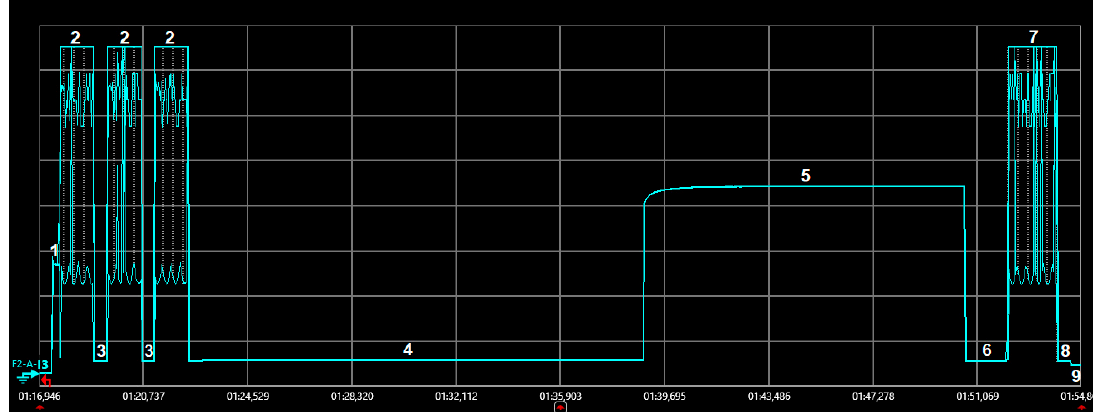
Figure 6. Current consumption profile of a MKRFOX1200 device during a bidirectional transaction initiated by the device. The uplink data message transmitted has a payload size of 1 byte.